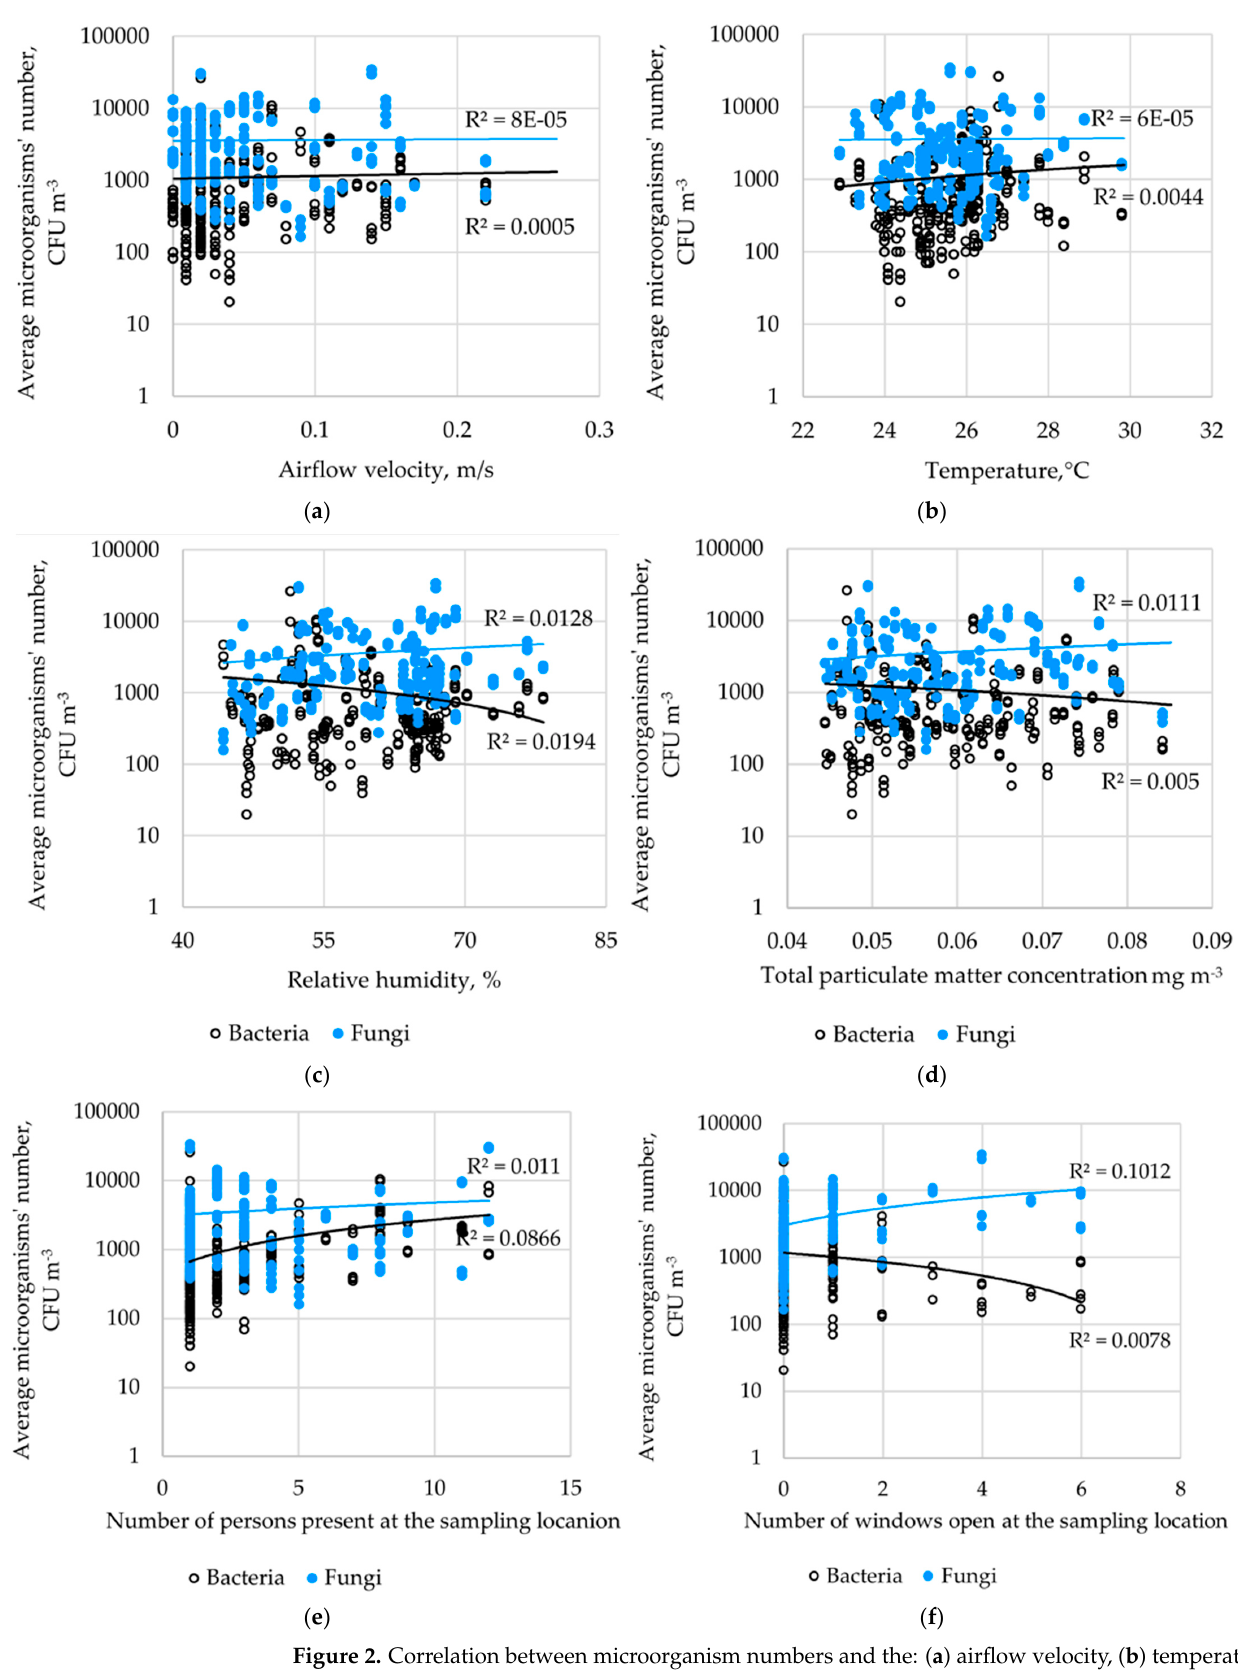
Figure 2. Correlation between microorganism numbers and the: ( a ) airflow velocity, ( b ) temperature, ( c ) relative humidity, ( d ) total particulate matter concentration, ( e ) the number of persons present at the sampling location, and ( f ) the number of windows open at the sampling